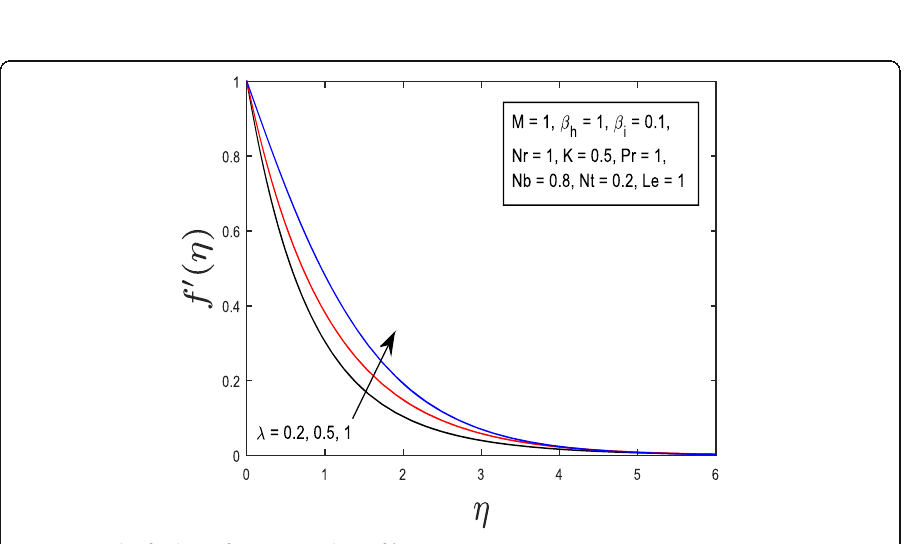
Fig. 12 Graph of velocity for various values of